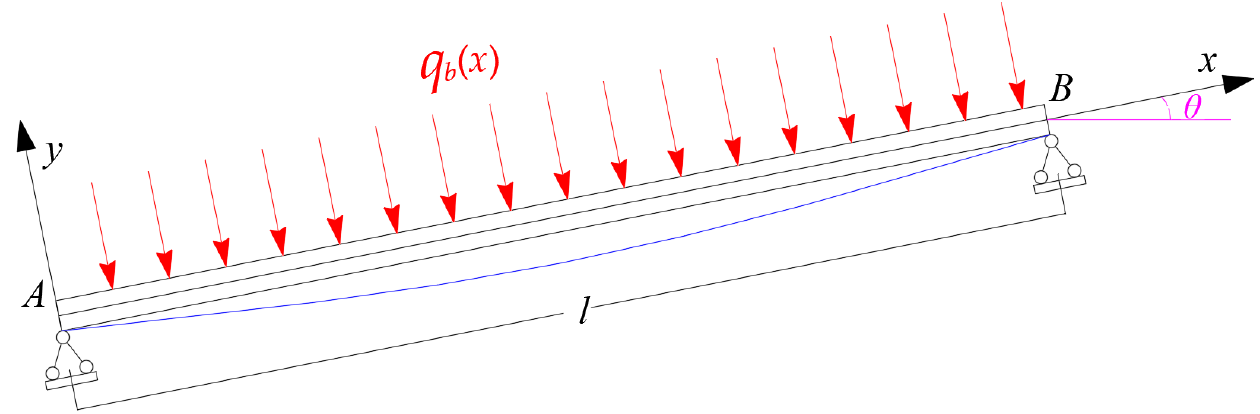
Figure 9. Bending deformation model of the rock beam.